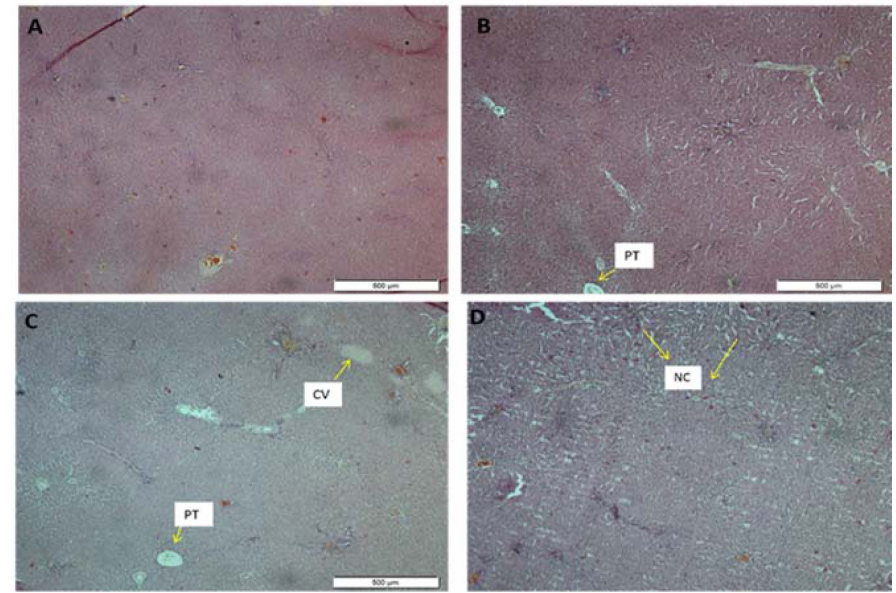
Figure 3. Liver sections stained with hematoxylin and eosin (H & E-stained under 40 ˆ magnification power) showing the effect of Alstonia scholaris methanolic extract (ASME) in a 28-day sub-acute toxicity study in female rats: ( A ) Control group; ( B ) 250 mg/kg; ( C ) 500 mg/kg and ( D ) 1000 mg/kg. Indicators: Portal Triad (PT); Central Vein (CV); Centrilobular Necrosis